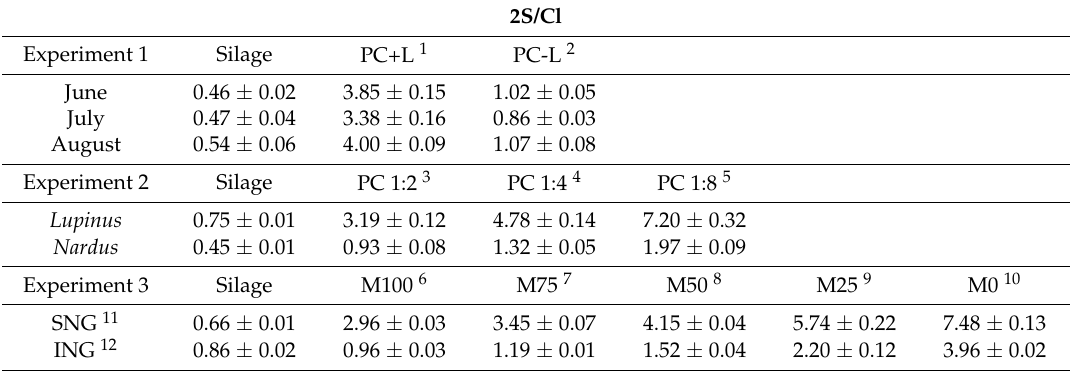
Table 5. Arithmetic means of 2S/Cl index in silages and press cakes (PC); ± indicates the standard errors of the